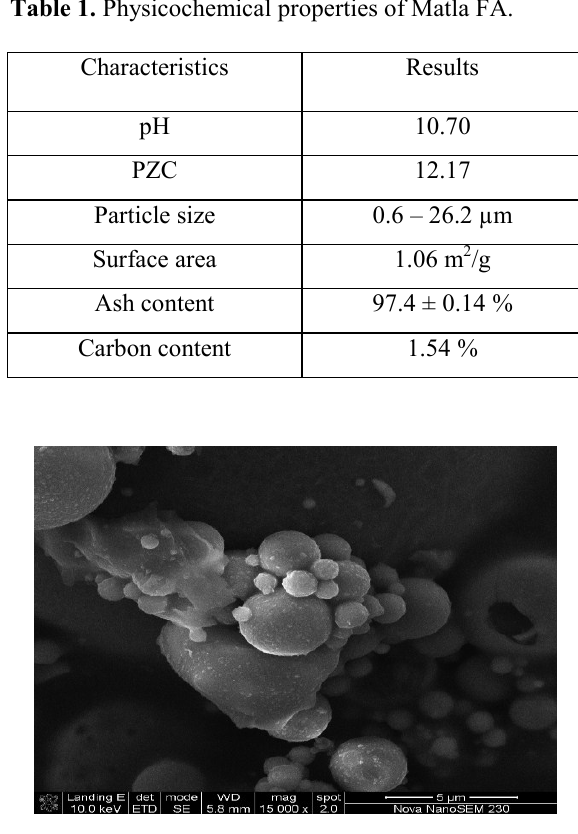
Figure 2: SEM of Matla